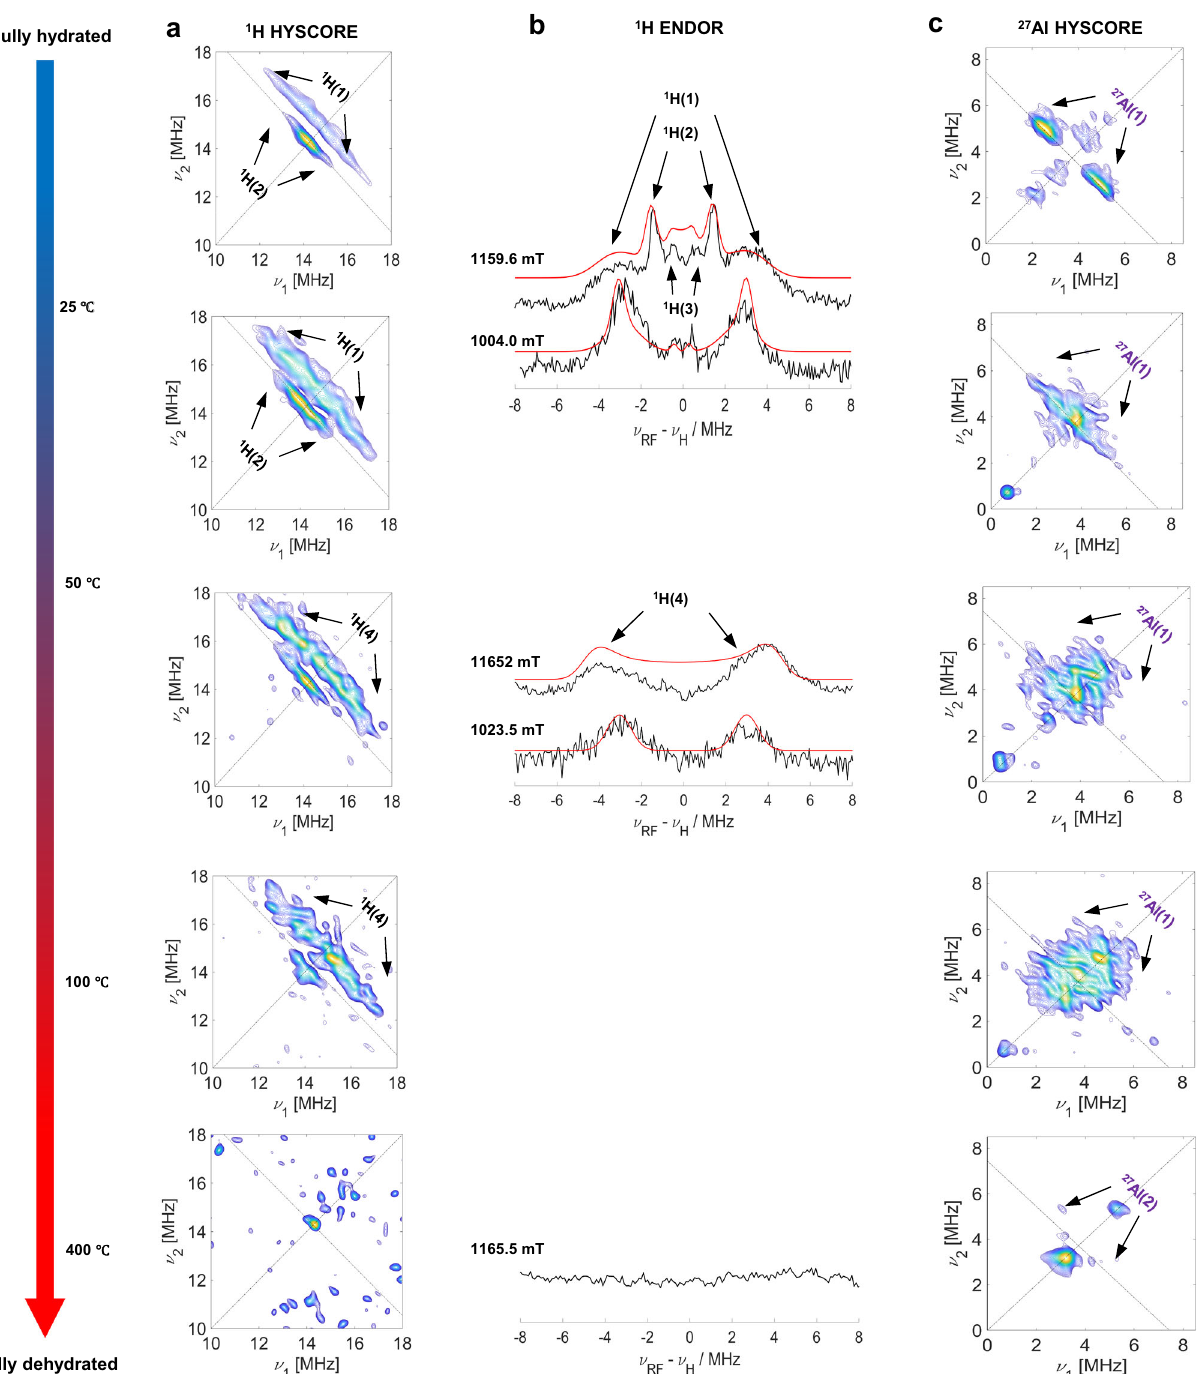
Fig. 2 HYSCORE and ENDOR spectra of Cu-CHA at different dehydration stages. a X-band 1 H HYSCORE spectra recorded at 4.5 K and obtained at the echo maximum intensity position of Cu-CHA gradually dehydrated. b Corresponding Q-band 1 H Davies ENDOR spectra (black line) acquired at 20 K at the fi eld indicated above the plot and their simulations (red line). c X-band 27 Al HYSCORE spectra recorded at same experimental conditions of 1 H HYSCORE spectra. 1 H and 27 Al signals are indicated by arrows. The parameters used in the simulation satisfy both HYSCORE and Davies ENDOR